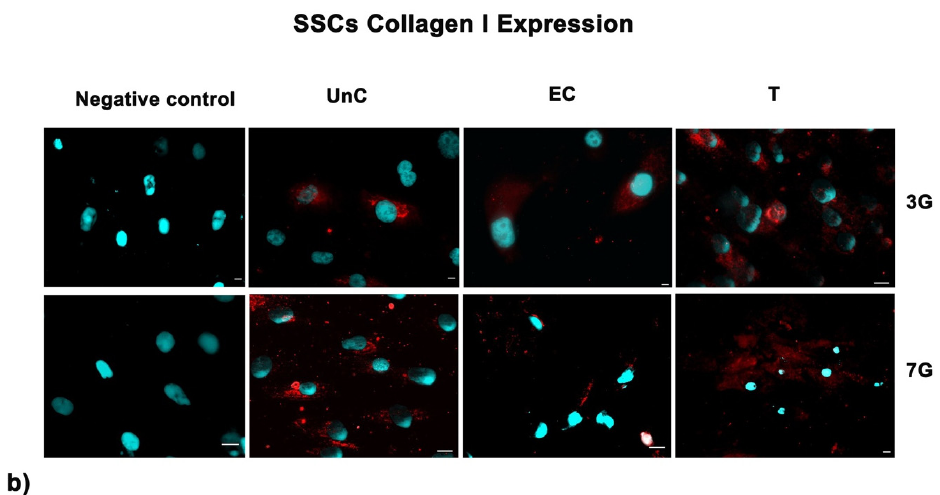
Figure 8. Analysis of collagen deposition after oxidative stress. Collagen type I images were acquired in HFF1 ( a ) and SSCs ( b ) exposed to UV treatment (EC) and cells pre-treated with NanoPCL-M and then exposed to UV radiation (T). Unexposed control cells were cultured in basic growing medium (UnC). Cells stained with a secondary antibody without any primary antibody were used as the negative control. Note that HFF1, or SSCs, analyzed for Collagen I expression, are the same cells that had been assessed for SIRT1 expression (Figure 6) using a double simultaneous incubation with two different antibodies, anti-mouse and anti-rabbit, as indicated in the Methods section. For each differentiation marker, fields with the highest yield of positively stained cells are shown. Nuclei are labelled with 4,6-diamidino-2-phenylindole (DAPI, blue). Scale bars: 40 µm.